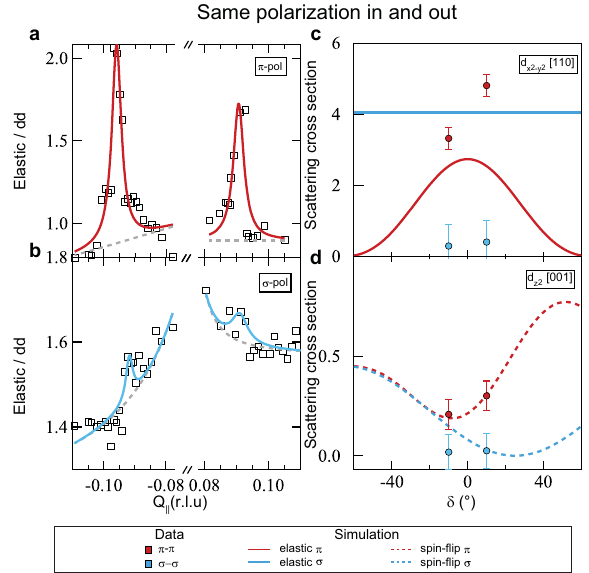
Fig. 2 Evidence for the d z 2 character of the Bragg peak of the x = 0.5 NYN-trilayer obtained at the Cu L 3 edge. a , b Normalized intensity of the elastic line from RIXS (open symbols) as a function of in-plane momentum transfer, Q || , of the incident X-rays for π - and σ -polarization, respectively. Solid lines are Lorentzian fi ts with a Gaussian background. The gray dashed lines highlight the back- ground contribution. The increased peak intensity for the π -polarized beam are in direct contrast to previous observations of charge order involving d x 2 (cid:1) y 2 orbitals. The combined uncertainty in Q || is ±0.005 r.l.u. c Geometric scattering cross-section calculations (solid lines) for an elastic d x 2 (cid:1) y 2 process as a function of angle δ . An angle of 0° corresponds to the Γ -point. The intensities of the Bragg peaks at the corresponding scattering conditions (obtained for each of the four cases in ( a ) and ( b )) are shown as markers (30× magni fi ed). The reversed polarization dependence compared with the calculations reveals the underlying orbital character cannot be d x 2 (cid:1) y 2 d The same calculation as in ( c ) for a spin- fl ip scattering process involving d z 2 orbitals, and spin oriented along the [001] direction. The d z 2 orbital symmetry correctly captures the reversal of the measured π and σ cross-sections (markers, 2× magni fi ed) compared with the d x 2 (cid:1) y 2 case, highlighting the role of d z 2 orbitals in the observed order. Errors were calculated using standard